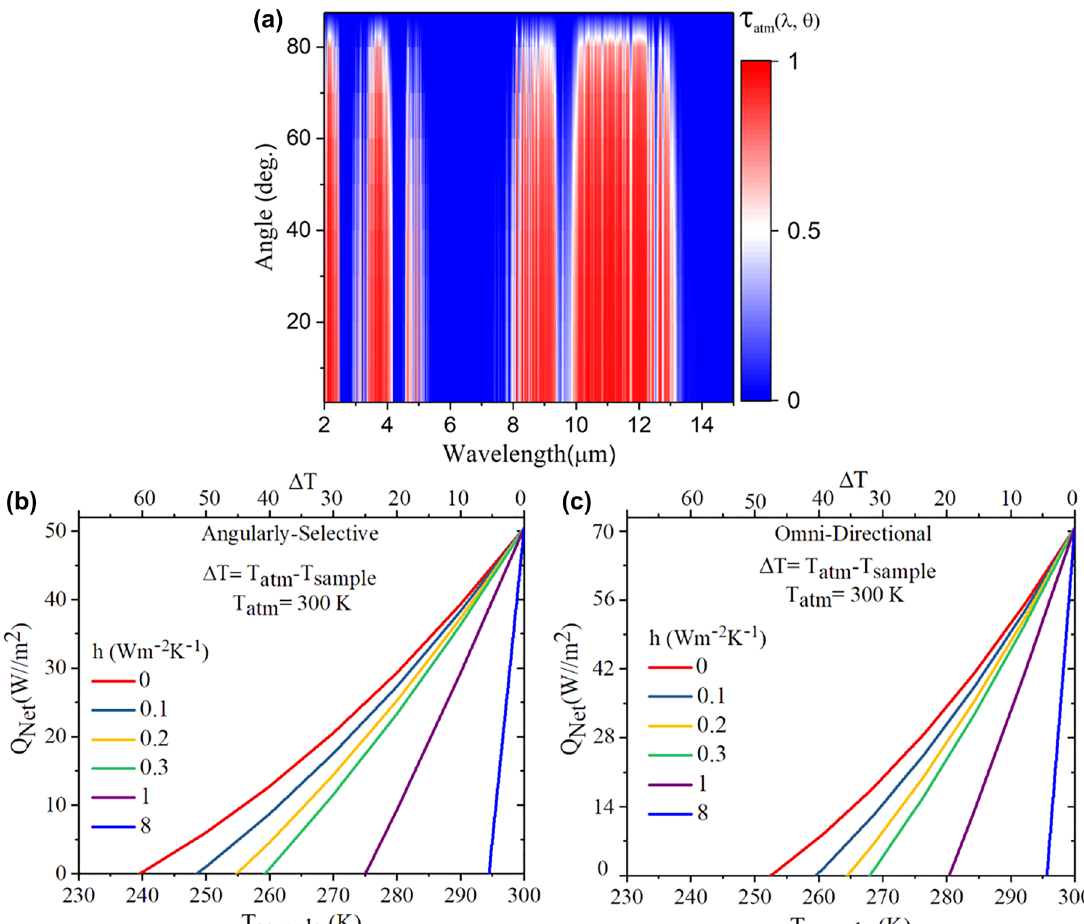
Figure 6: Steady state temperature of thermal emitter. (a) Atmospheric emissivity as a function of angle and wavelength at relative humidity as a function of the sample temperature T at different parasitic heat transfer coefficient heat h keeping of 20%. Net power out Q net sample at 300 K for (b) the porposed angularly and spectrally selective thermal emitter and (c) the same thermal atmospheric temperature T atm emitter without the iridescent transmission filter shown in Figure 5a. The steady state temperature and temperature difference − T = 0 for different h (W m − 2 K − 1 ) = 0 , 0.1 , 0.2 , 0.3 , 1 and 8 are 60 ◦ C, 51 ◦ C, 45 ◦ C, 40 ◦ C, 25 ◦ C and 6 ) corresponding to Q ( Δ T = T atm sample net ◦ C, respectively for (b) the proposed angularly and spectrally selective emitter and 48 ◦ C, 40 ◦ C, 35 ◦ C, 31 ◦ C, 19 ◦ C and 4 ◦ C for (c) the spectrally selective